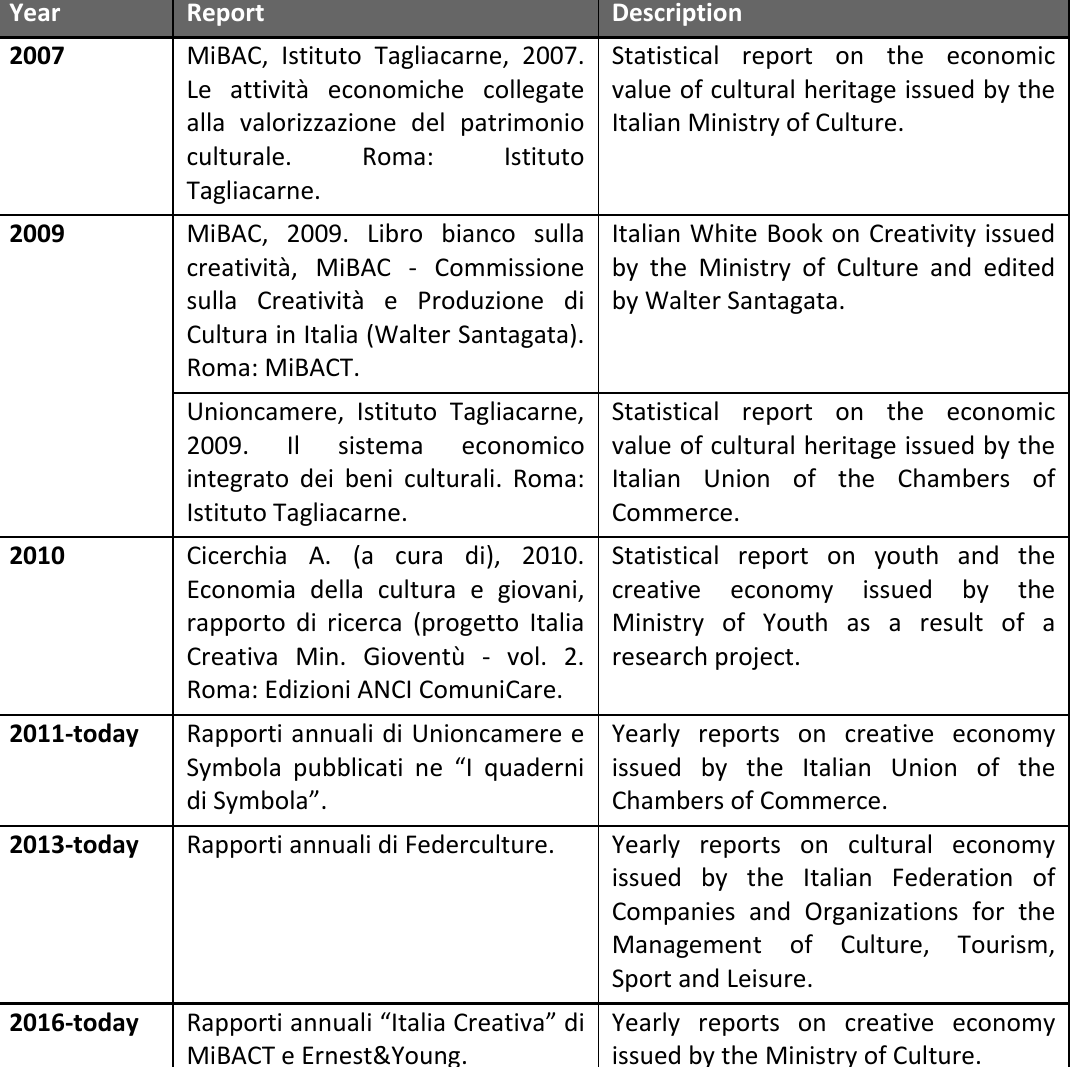
Table 2: Reports at the base of the statistical framework adopted in the